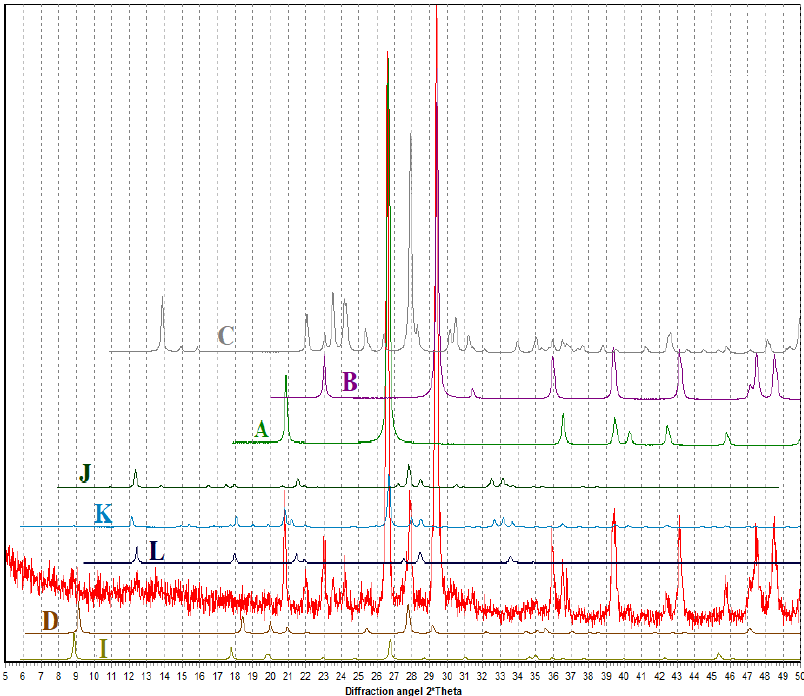
Figure 8. Diffraction patterns of the AAM based on thermally treated (700 °C) marl (sample TM1), in comparison with the database PDF-2. The comparison phases are as follows: A—quartz, B—calcite, C—albite, D—paragonite, I—muscovite, J—phillipsite, K—gismondite, L—garronite.